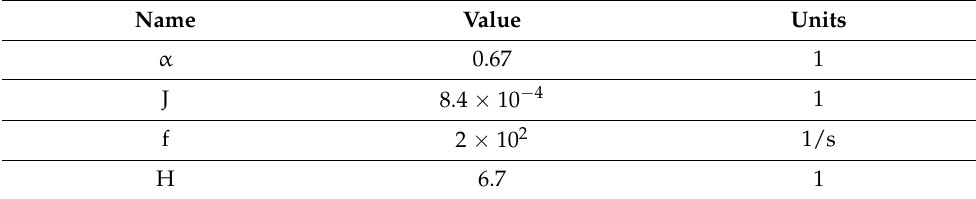
Table 1. Aging Parameters.